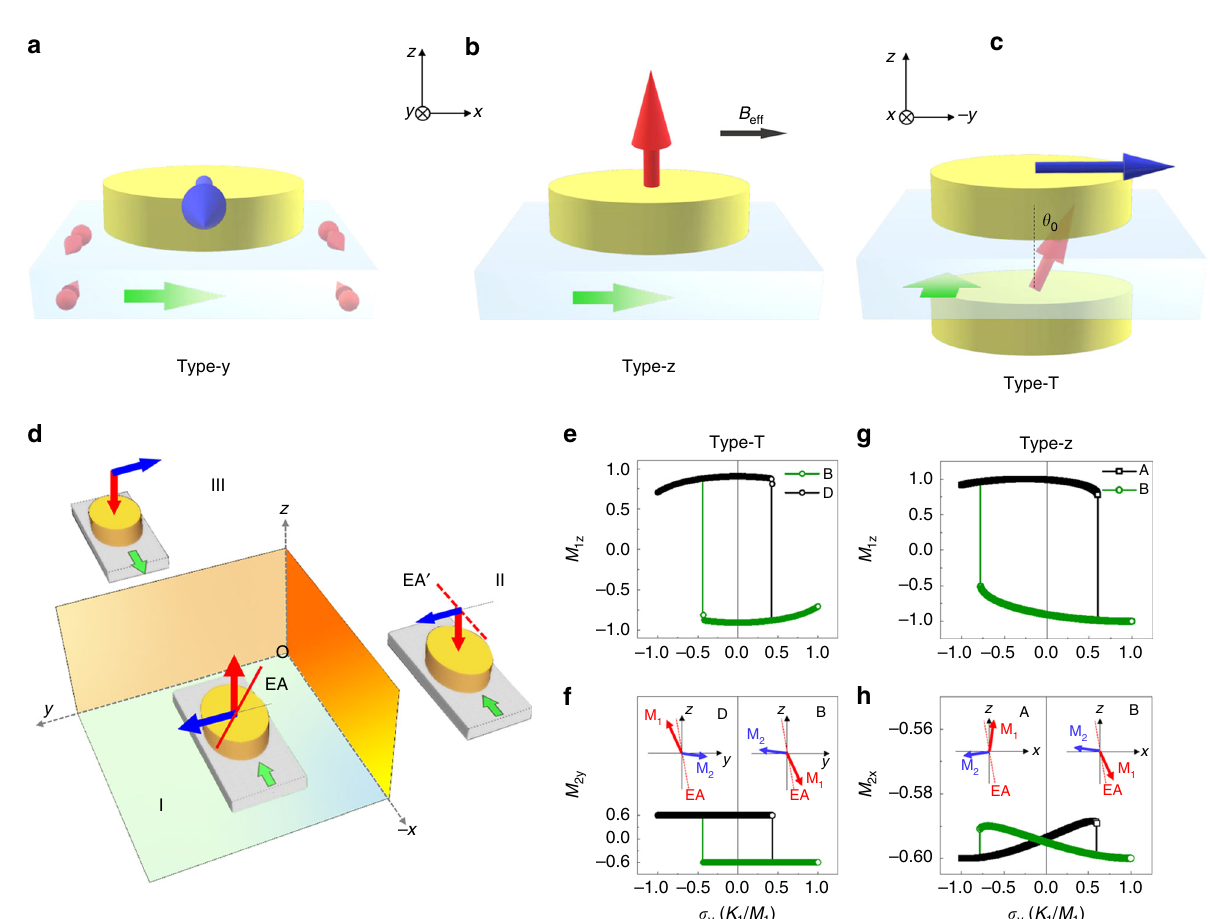
Fig. 1 Different SOT-switching modes. a – c Type-y, Type-z, and Type-T mode. Green, red, and blue arrows denote current, magnetization of PMA, and IMA layers, respectively. d Symmetry breaking in Type-T mode. A tilting EA of PMA indicated by red solid or dashed line is necessary. e , f Simulated σ dependence of M 1z and M 2y in Type-T mode in which current is vertical to EA of the IMA layer. g , h Simulated σ dependence of M 1z and M 2x in Type-z mode in which current is parallel to EA of the IMA layer. Spin con fi gurations before and after switching are shown as